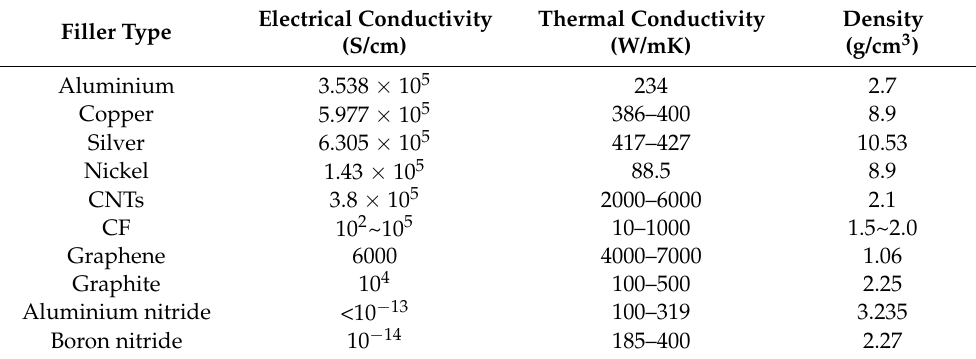
Table 1. The conductivity of metal and carbon